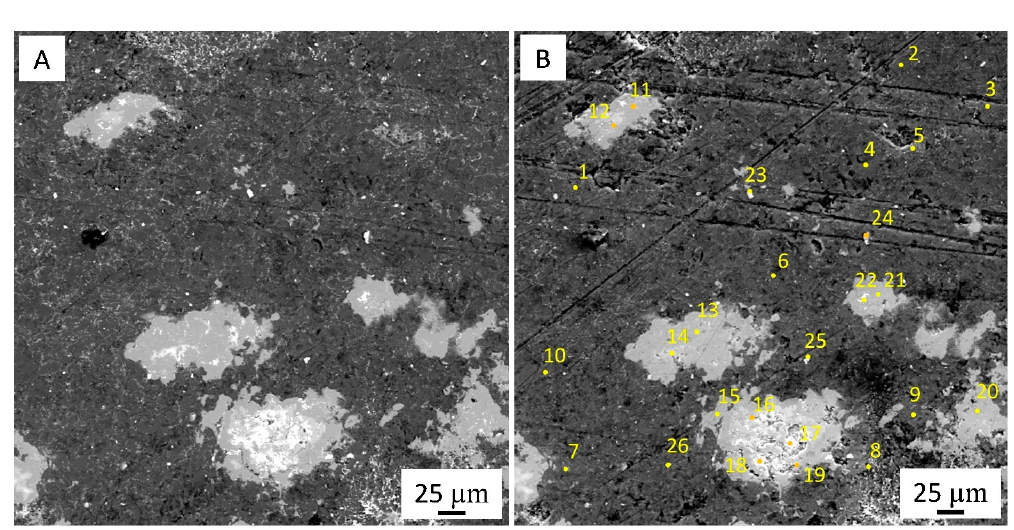
Figure 5. SEM BSE mode ( A ) and SE mode ( B ) with EDS analysis points images of the M3 alloy.